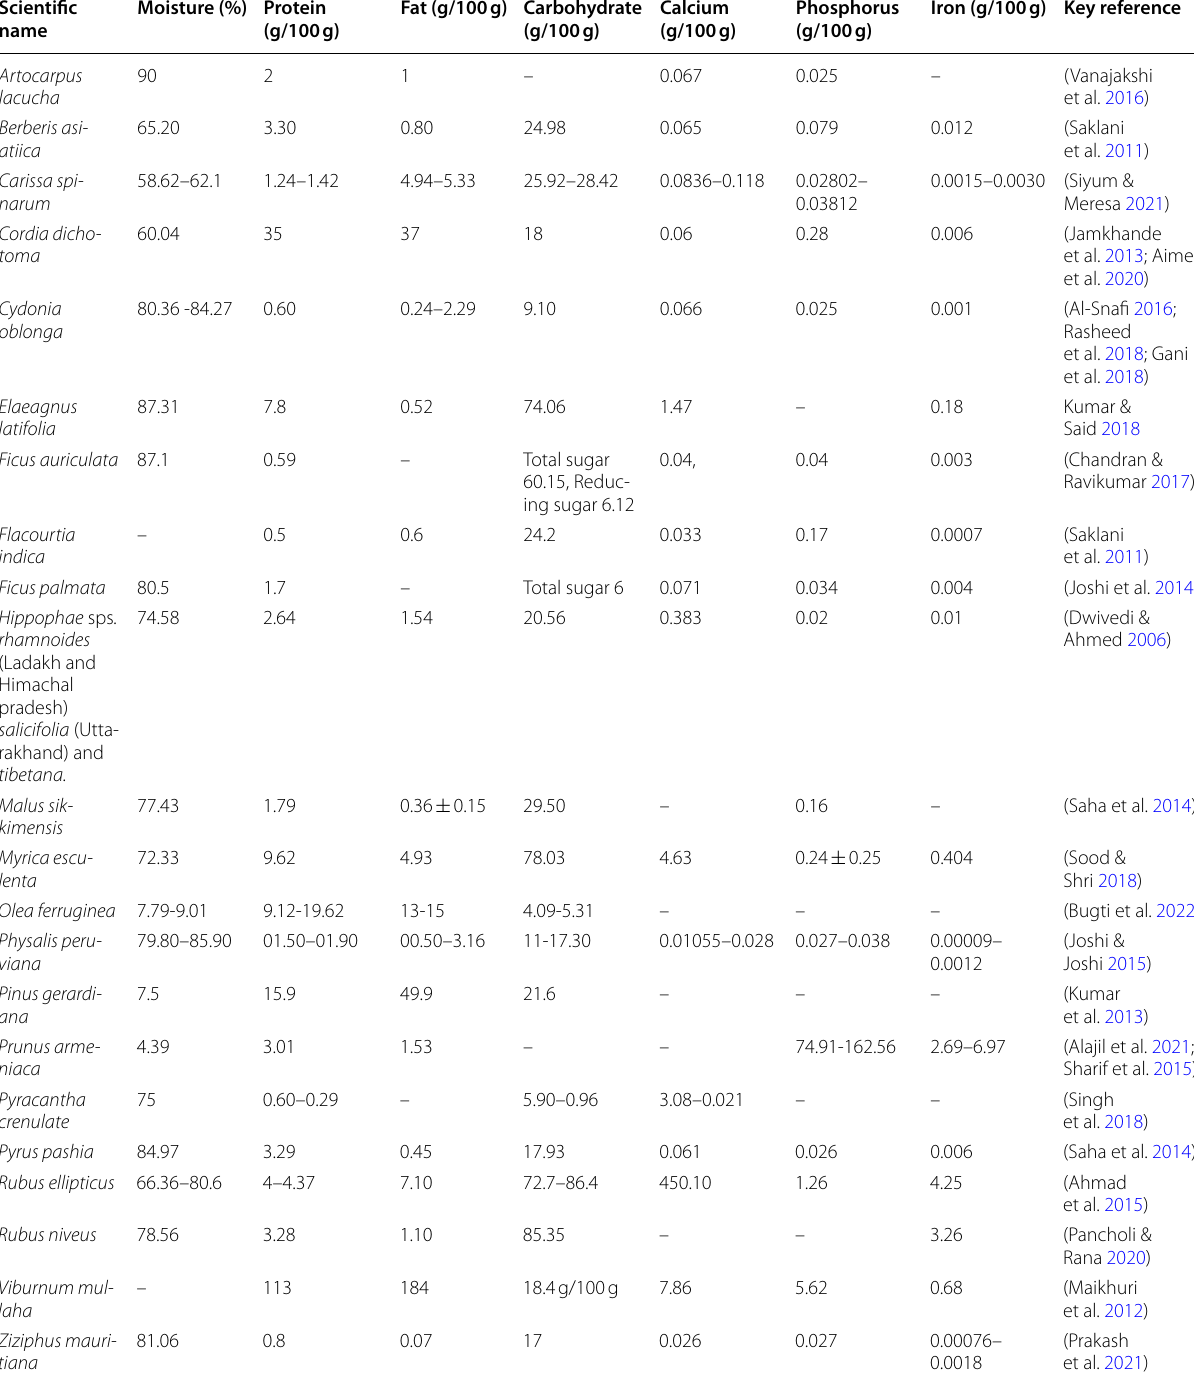
Table 3 Nutritional profile of underutilized fruits of the Northern